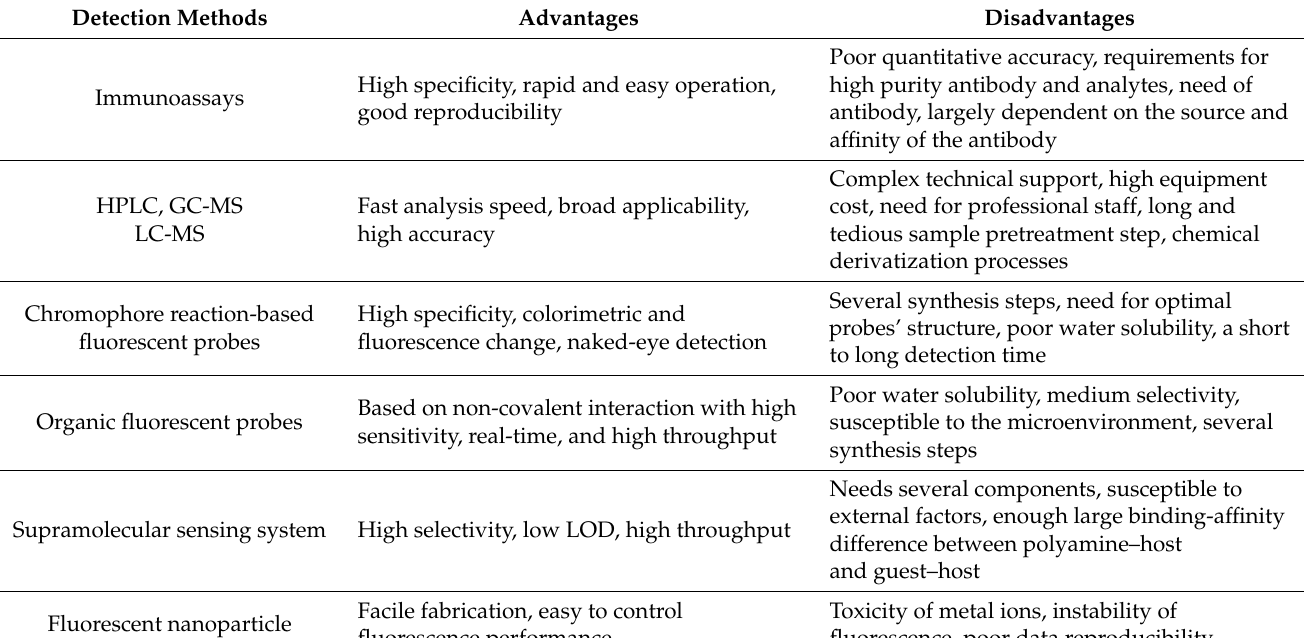
Table 1. Performance comparison of related polyamine monitoring